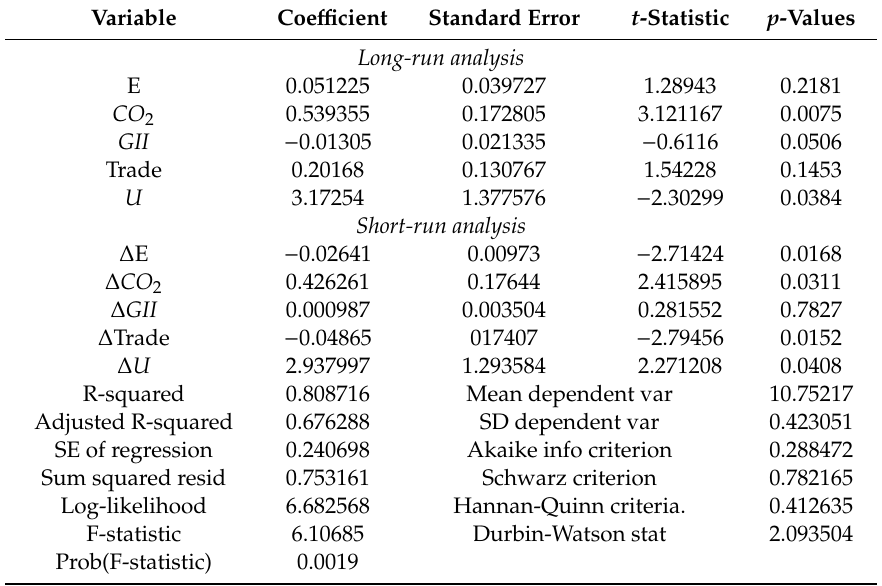
Table 8. The results of long and short-run estimates. Selected Model: ARDL (1, 1, 0, 0, 1, 0). Variable